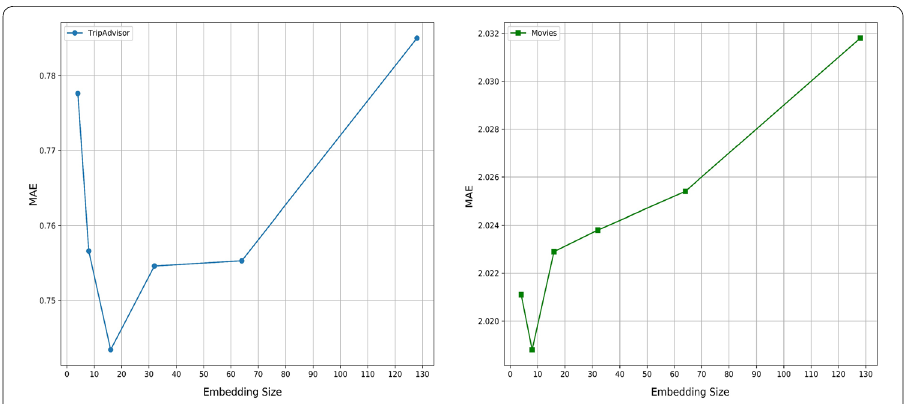
Fig. 3 The impact of embedding vector size in MF model for both